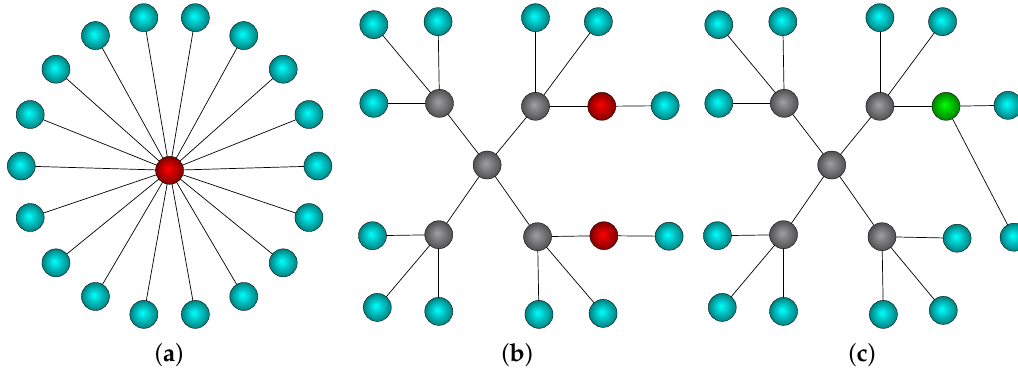
Figure 2. Tree based topologies: ( a ) star; ( b ) expert; and ( c ) improved solution